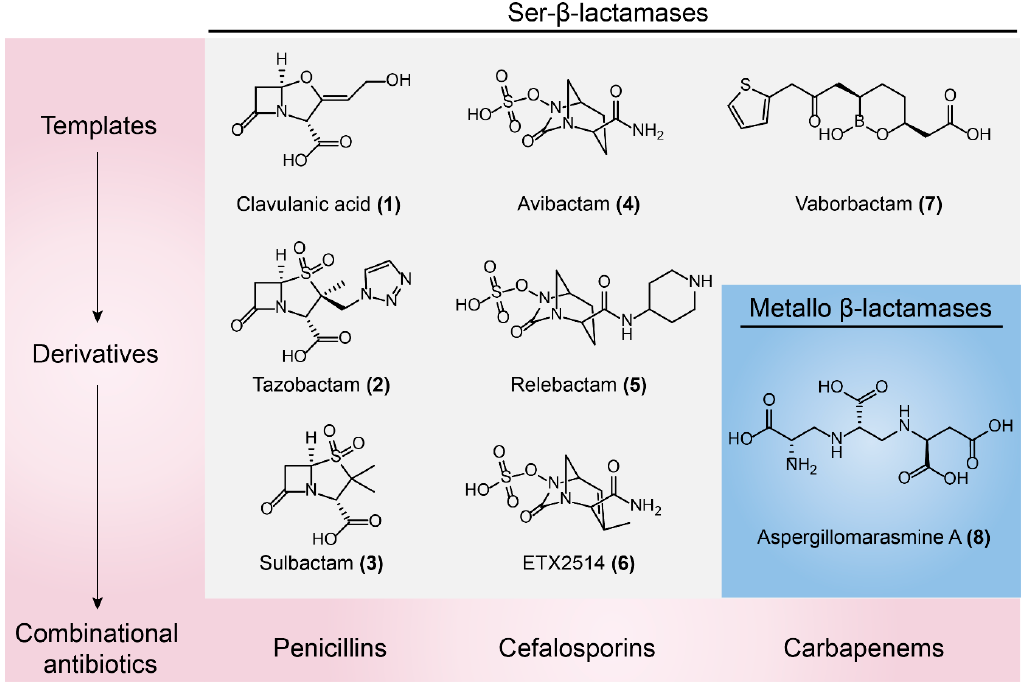
Figure 9. Inhibitors of Ser ‐β‐ lactamases and metallo ‐β‐ lactamases. The chemical structures, templates, derivatives of β‐ lactamases inhibitors, and commonly paired antibiotics are shown.